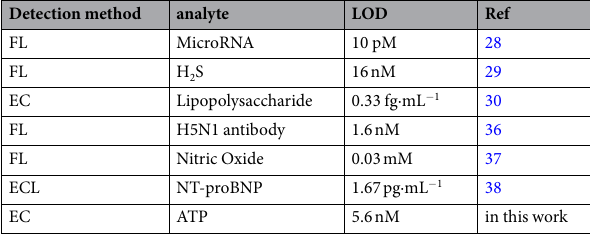
Detection method